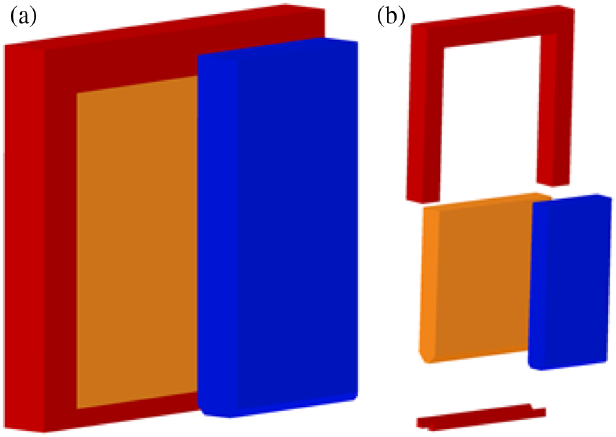
FIG. 3. (Color) Praseodymium magnet design with samarium- cobalt sheath. Part (a) shows one quarter of an undulator period. The red samarium-cobalt sheath surrounds the more easily demagnetized, at room temperature, orange praseodymium mag- net. Half of the blue steel pole has been cut away to reveal the structure of the assembly. Part (b) is an exploded view of (a) which shows that the bottom pieces of samarium-cobalt are used to fill in the chamfers of the praseodymium magnet. This is useful because having more strong magnet material near the beam axis promotes field quality. Although the chamfer samarium-cobalt fill-ins are naturally attracted to the praseody- mium magnets, some form of adhesive or mechanical restraint will be required. From an engineering standpoint it is easier to replace the fill-ins with a full strip of samarium-cobalt and make the praseodymium magnet a simple block.